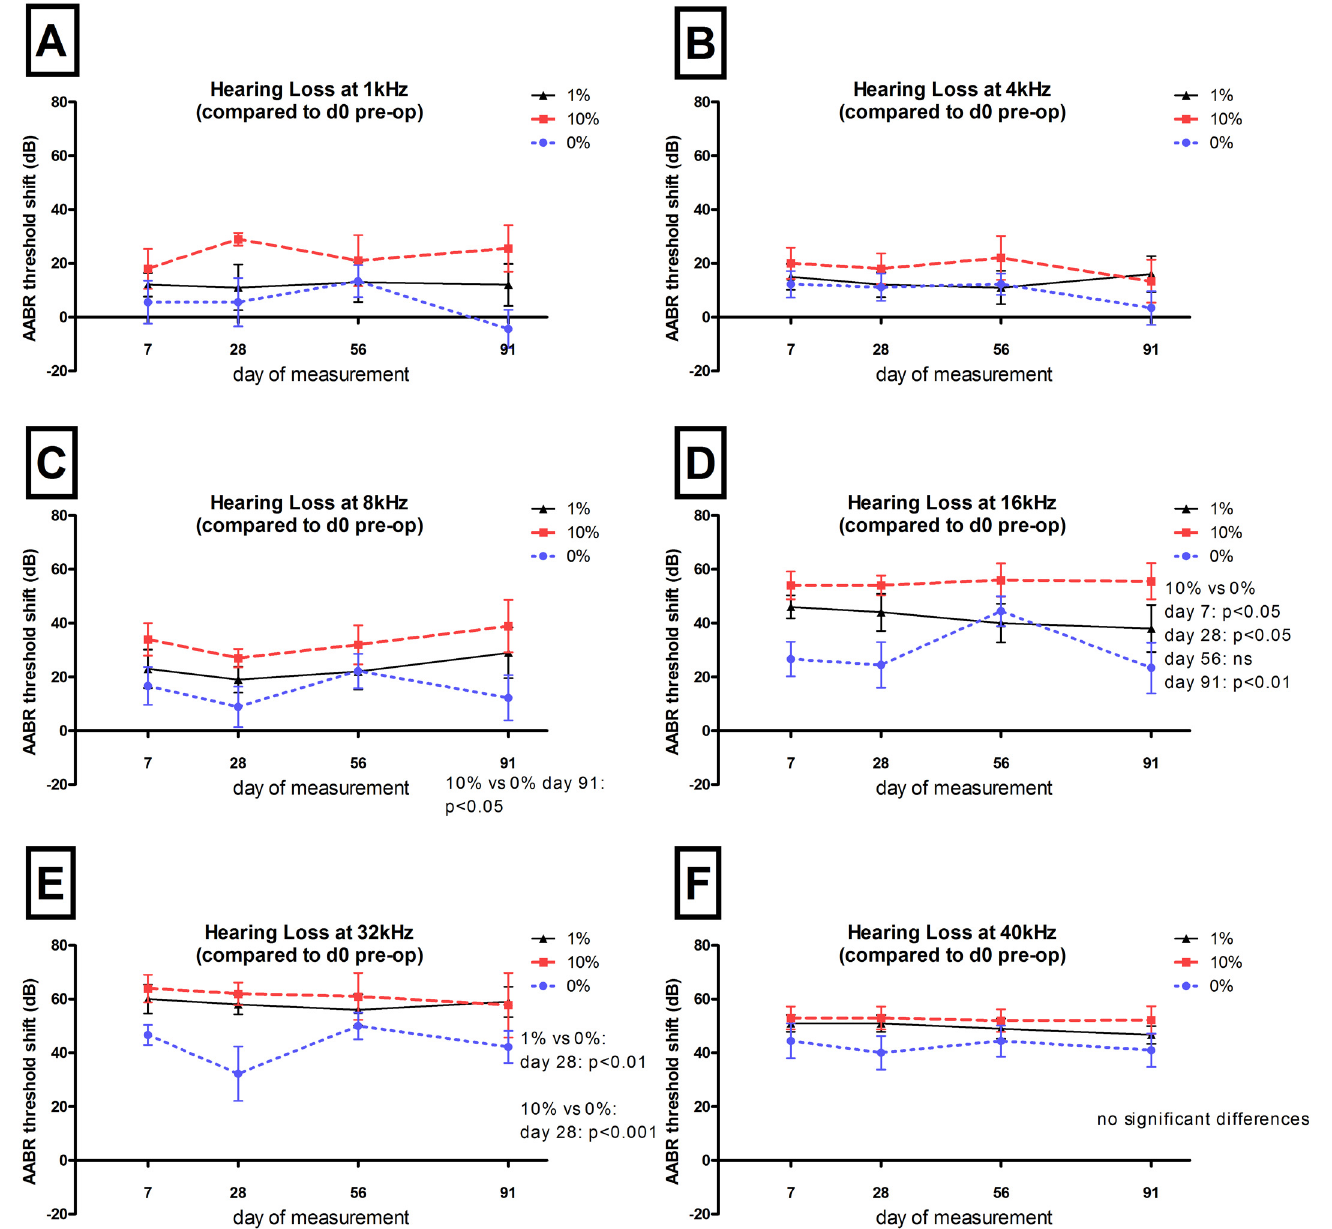
Fig 7. AABR threshold shifts related to day 0. The mean and SEM AABR threshold before electrode insertion is plotted as a function of time. Significant differences in hearing thresholds are listed in the respective graphs. DEX eluting electrodes did not protect residual hearing at any frequency. At the lowest frequencies (1 and 4 kHz) and at the highest frequency tested (40 kHz), no significant differences were detected between the groups. At 8, 16, and 32 kHz DEX treated animals had an increased hearing loss compared to control (0%